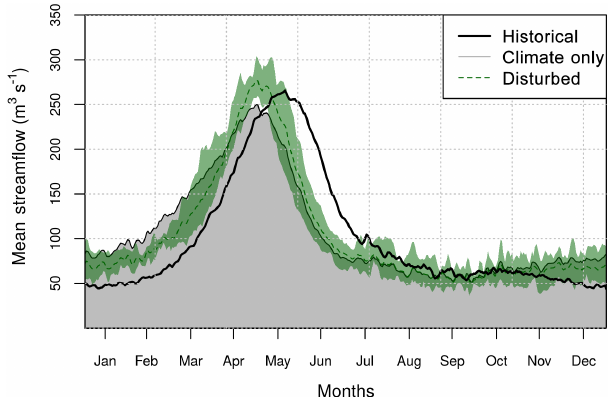
Figure 4. The characterization of hydrological changes associated with climate change requires a consideration of vegetation dis- turbance, as indicated by a number of simulations of San Juan River basin streamflow with the variable infiltration capacity (VIC) model. Several simulations are considered here: one using historical (1970–1999) meteorological forcing (average streamflow shown as a thick black line) and others using future (2070–2099) temperature and precipitation forcing from the Intergovernmental Panel on Cli- mate Change (IPCC) CMIP5 database (four different sets of forcing from four different Earth system models, or ESMs). Future stream- flow conditions are provided for two vegetation disturbance scenar- ios. The thin black line (with gray shading underneath) represents the average seasonal cycle of simulated streamflow from future runs which utilize the historical representation of vegetation. The green envelope (mean is shown as a dashed green line), on the other hand, represents the range of average seasonal cycles produced in future runs (one for each of the four ESMs) that results from the imposed forest mortality of close to 90% by the 2080s, based on work from McDowell et al. (2016). We see that for the San Juan River basin, a major tributary to the Colorado River basin, spring freshet in the future runs occurs earlier in the season, shifting from mid-May to the end of April. Flows are projected to be higher during late fall, winter, and early spring, and lower during late spring, summer, and early fall. Disturbing the vegetation in addition to using projected temperature and precipitation forcing results in a different pattern of streamflow, with lower flows in early spring and then higher peak flow, and with lower recessional summer flows due to differ- ences in how regrowth vegetation (i.e., shrubs) partitions water and snowpack. Studies on climate change thus require a consideration of changes in vegetation dynamics; otherwise results may be mis- leading or could underestimate impacts. (Contact: Katrina